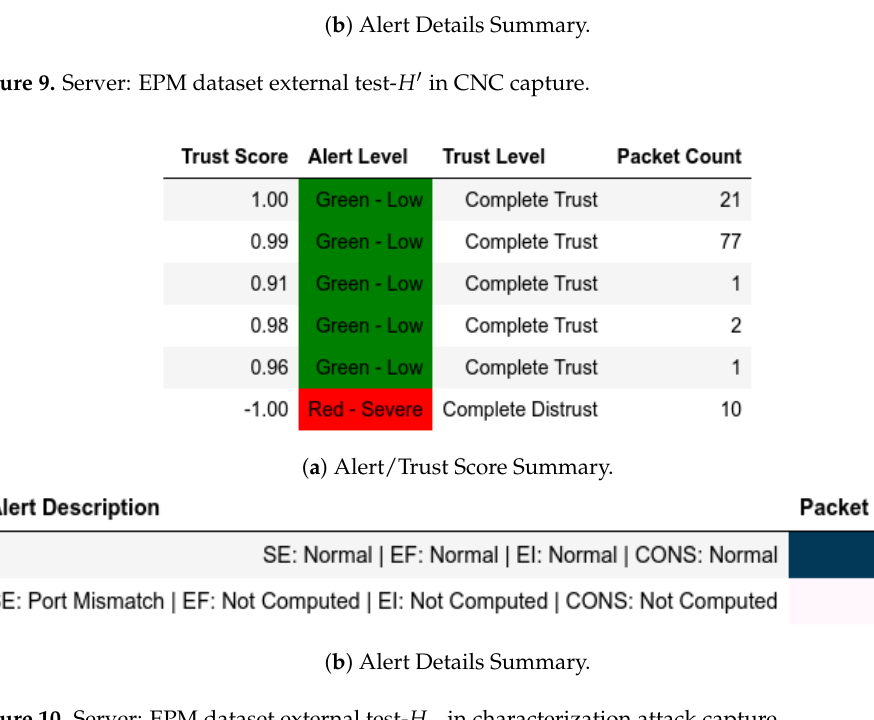
Figure 10. Server: EPM dataset external test- H m in characterization attack